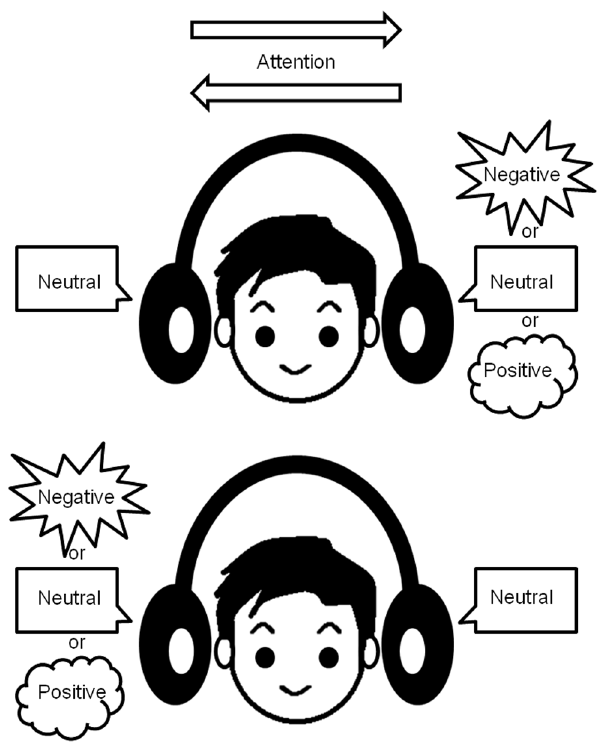
Figure 1. Experimental paradigm. Participants were asked to selectively attend to either the right- or left-sided voice stimulus within a pair. Then, they were required to select the word heard at the attended ear from four presented candidate words on the screen as quickly as possible. Orthogonally to the task demands, voices could have a semantically different emotional valence, either neutral on both sides, negative (or positive) on the attended side and neutral on the other side, or vice versa, neutral on the attended side and negative (or positive) on the other side.